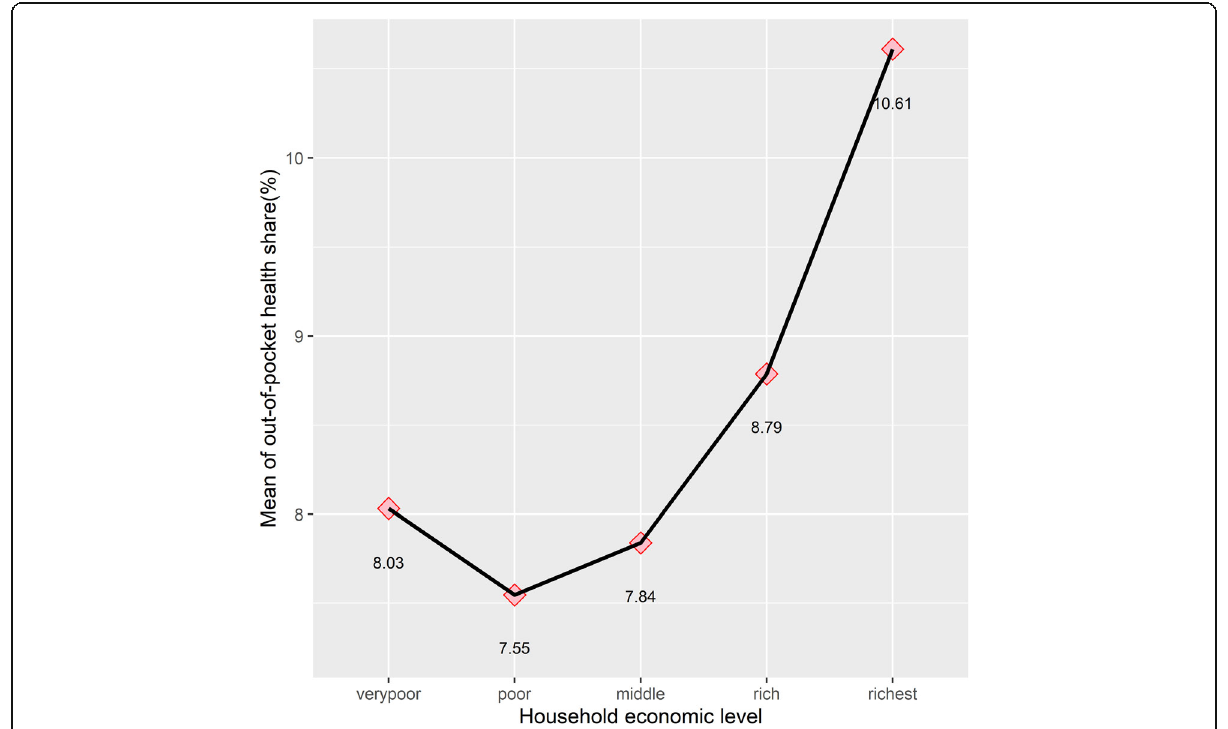
Fig. 1 The mean out-of-pocket health share by economic